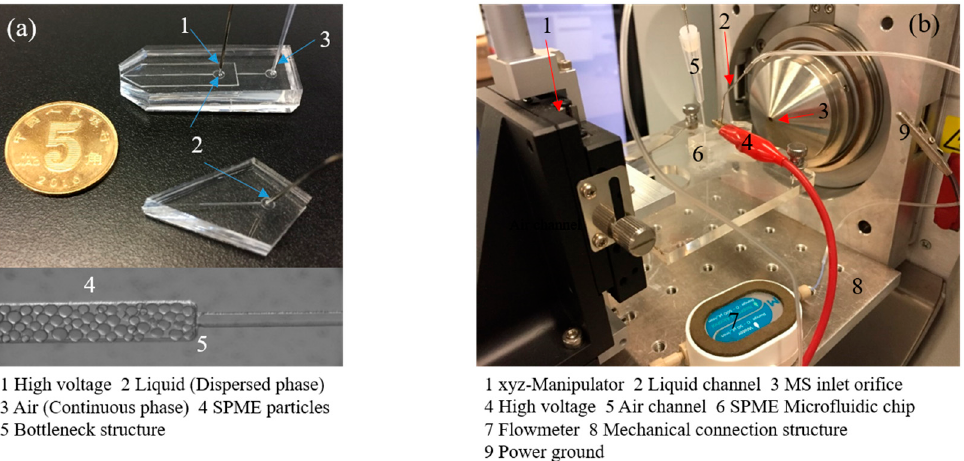
Figure 3. Microfluidic SPME module and laboratory-built experimental platform: ( a ) Microfluidic chips with SPME particles at bottleneck structure and ( b ) The configuration of the laboratory-built experimental platform coupling with mass spectrometry (MS).